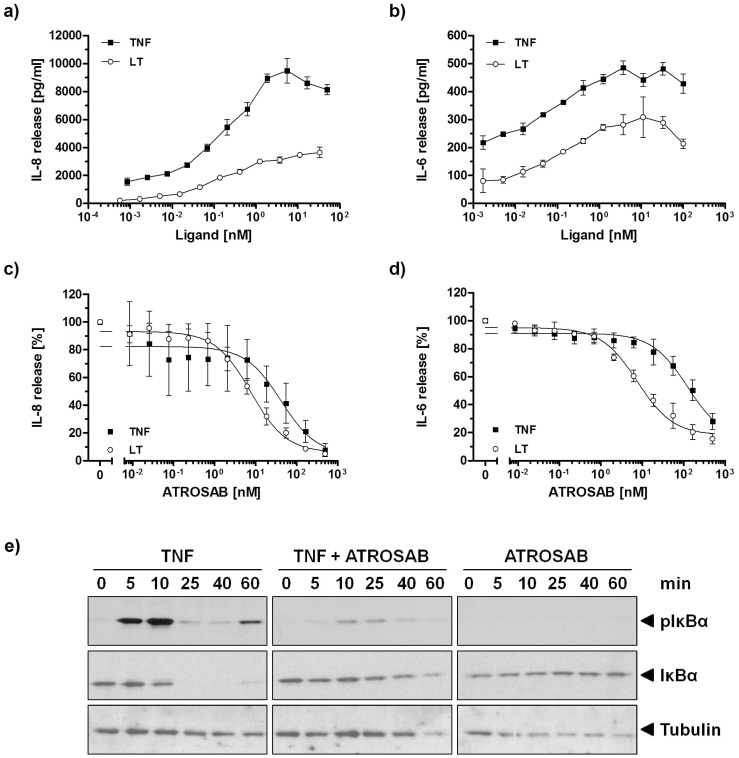
Inhibition of TNF and LTα action by ATROSAB.a) IL-8 release by HT1080 cells triggered by TNF and LTα b) IL-6 release by HeLa cells triggered by TNF and LTα. c) Inhibition of TNF- and LTα-induced IL-8 secretion by HT1080 cells with increasing concentrations of ATROSAB using 0.1 nM of TNF and LTα. d) Inhibition of TNF- and LTα-induced IL-6 secretion by HeLa cells with increasing concentrations of ATROSAB using 0.1 nM of TNF and LTα. Data from n = 3 experiments are shown as percent of maximal binding (c, d), shown are mean values and standard deviation. e) Immunoblot analysis of inhibition of TNF-induced phosphorylation (pIκBα) and degradation of IκBα in HT1080 cells by excess amounts of ATROSAB. Tubulin was included as loading control.